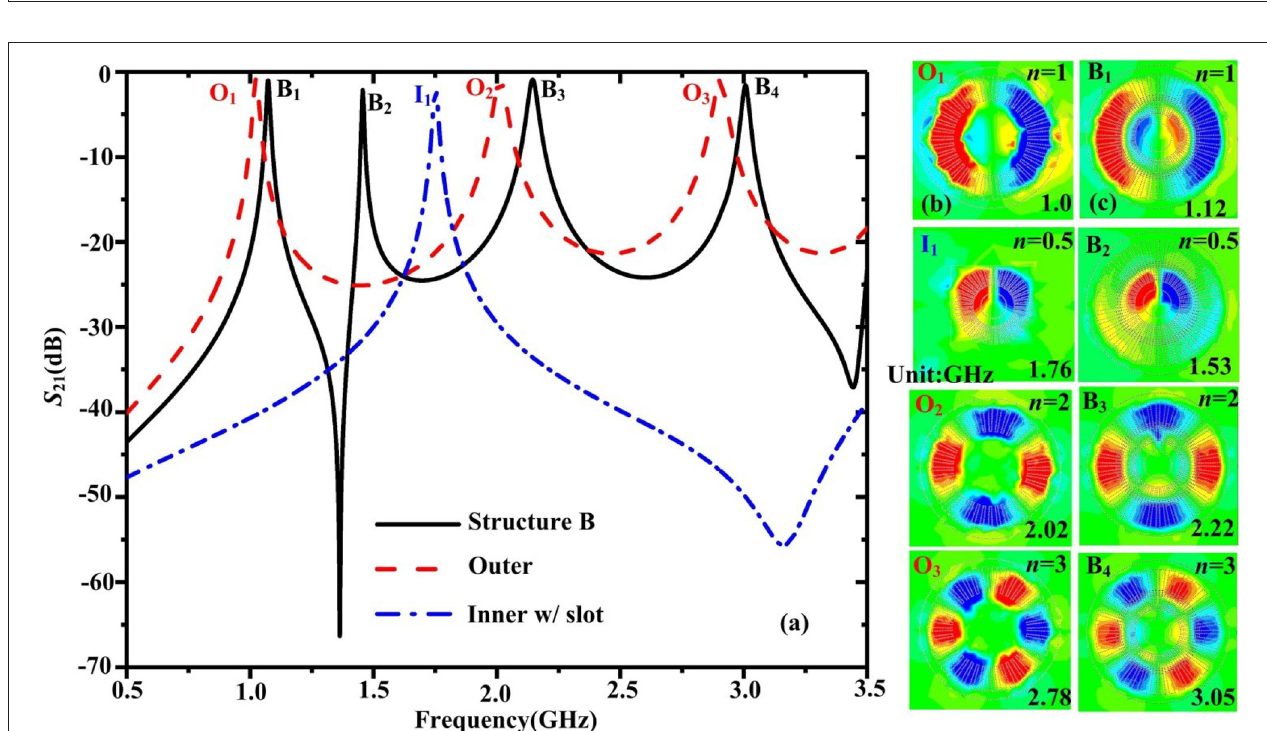
FIGURE 4 | (a) Simulation transmission coefficients S 21 of Structure B, outer corrugated ring, and inner corrugated ring with a slit. Two-dimensional E z -field distributions on the xoy plane 2mm above (b) the spoof LSPs resonators and (c) Structure B.